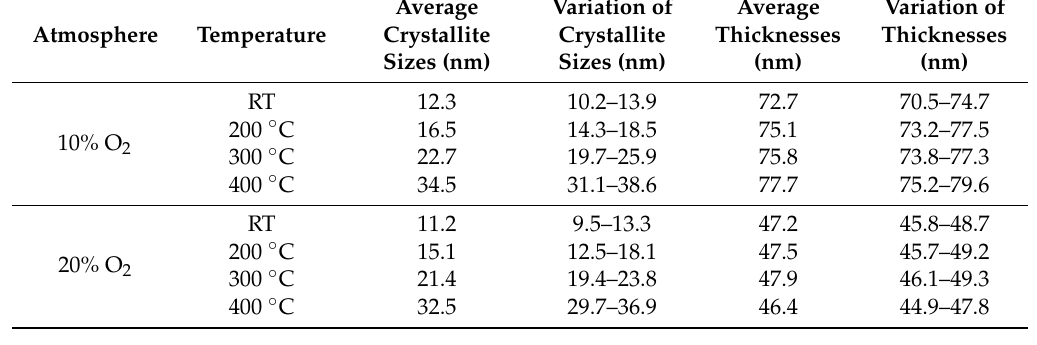
Table 1. Average crystallite sizes, variation of crystallite sizes, average thicknesses, and variation of thicknesses of Nb 2 O 5 thin films.